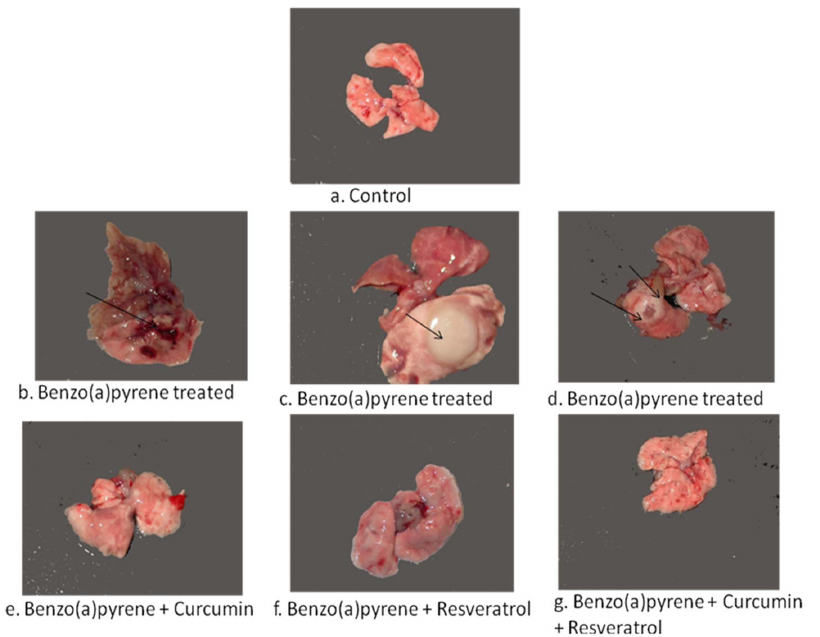
two compartments. 14 C-labeled substrate and the tissue sample were placed in one compartment, the inner vial and the other compartment, the outer vial contained a Whatman-I filter wick impregnated with scintillation flours and alkali. 14 CO 2 produced through respiration in the sample compartment is trapped on the wick and was measured in a liquid scintillation counter.